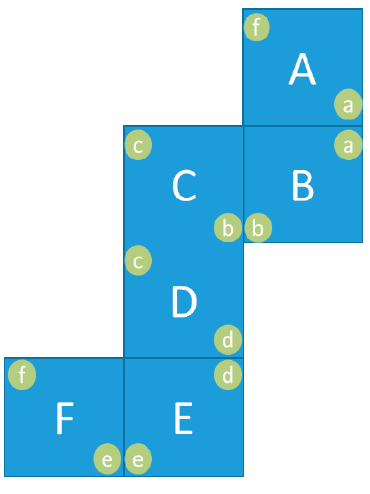
Figure 18. Sides and LDR location with names.